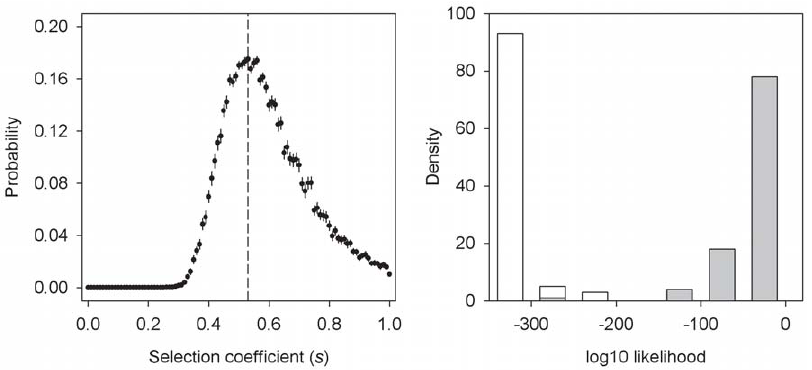
Figure 2. Selection of the N2 wild isolate pas15121 allele. Left panel shows the probability distribution of having selection coefficients ( s ) explaining the allele frequency changes observed during the derivation of the androdioecious population at marker pas15121 (see Materials and Methods ). Error bars indicate the standard error of the mean of the likelihoods of 100 replicate simulations of the funnel cross, with the dashed line indicating the best estimate of s . Similarly at the right panel, distributions of log10 likelihood estimates of allele frequency changes in 19 SNPs, from X- chromosome positions 3,054,487 bp to 5,819,445 bp, for neutral sampling in empty bars, or as grey bars for selection at marker pas15121 with s =0.53. For each of the 100 simulated replicates compound likelihoods are calculated by multiplying the probability of observed frequencies given the simulated frequencies of each marker.